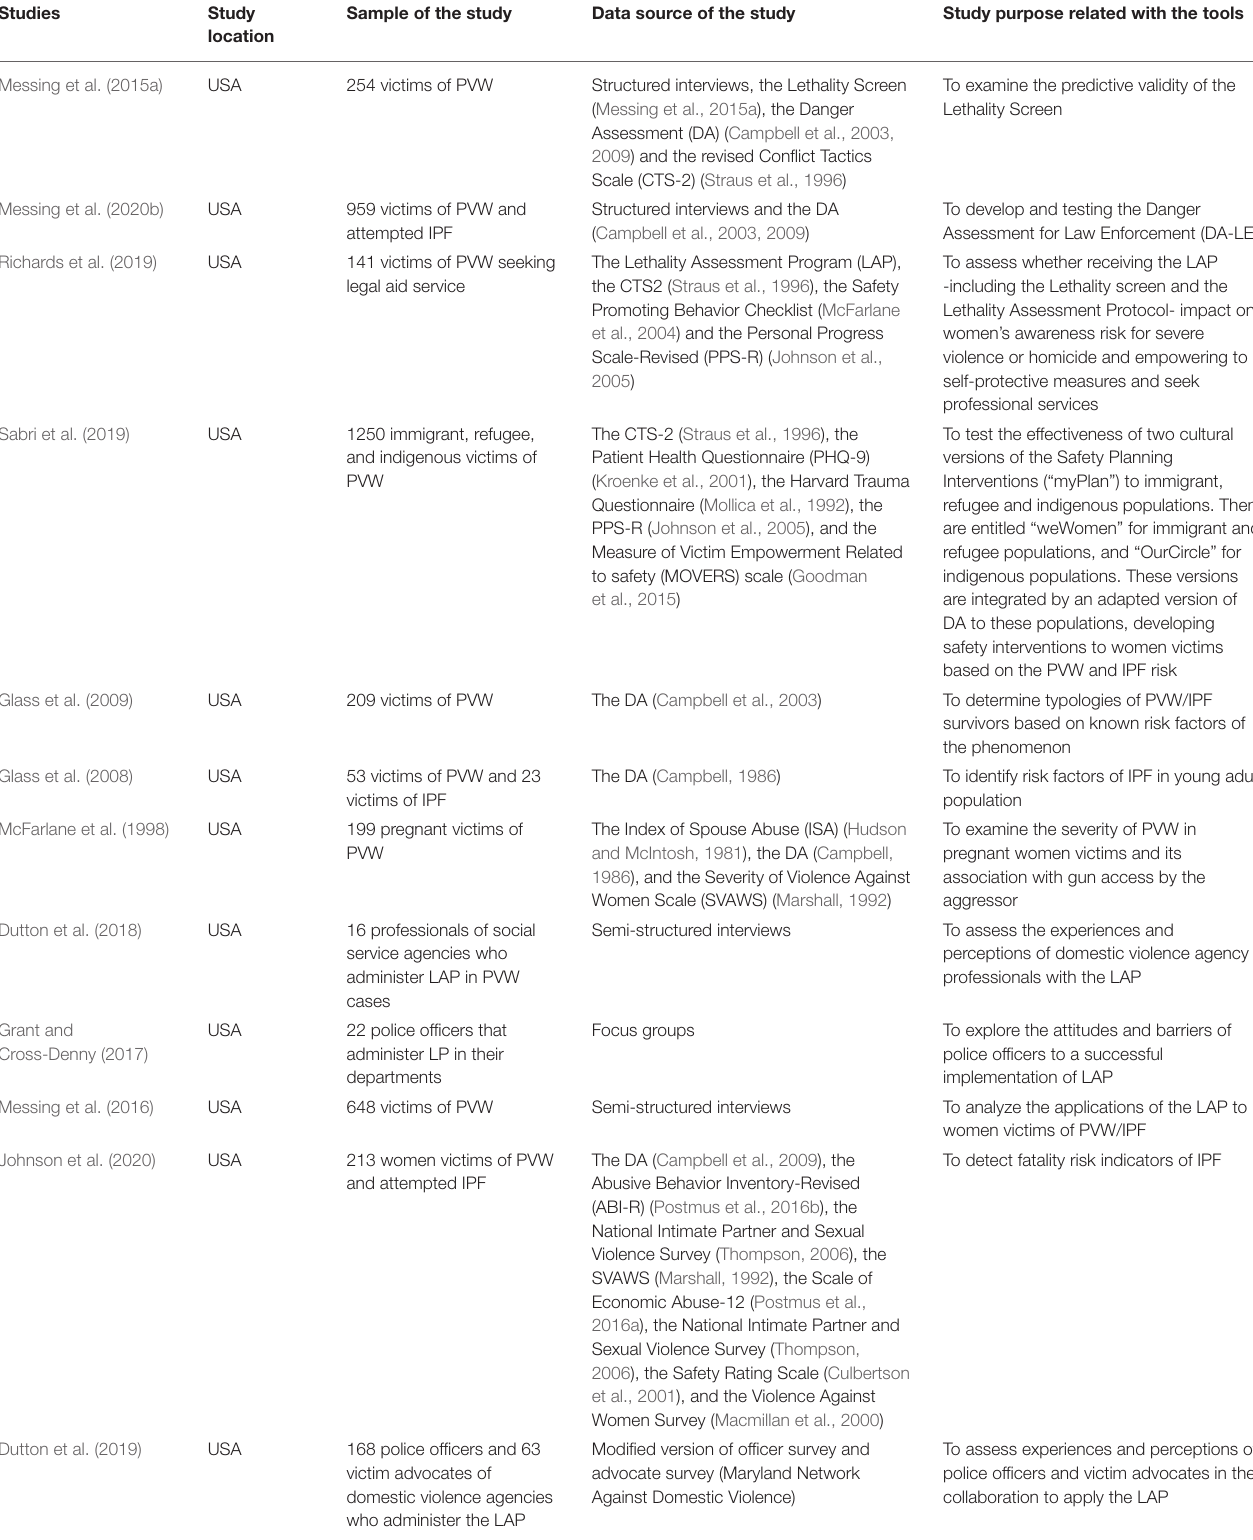
TABLE 1 | Characteristics of the included studies in the systematic